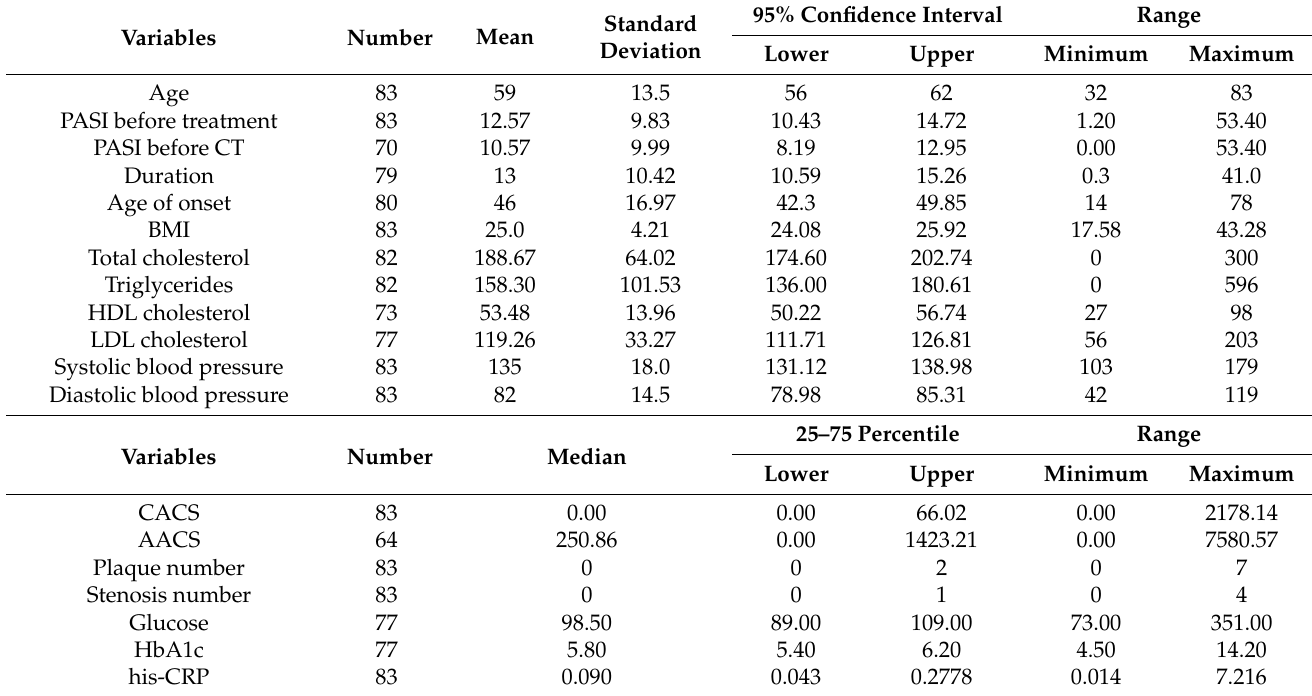
Table 5. Clinical data and test results of